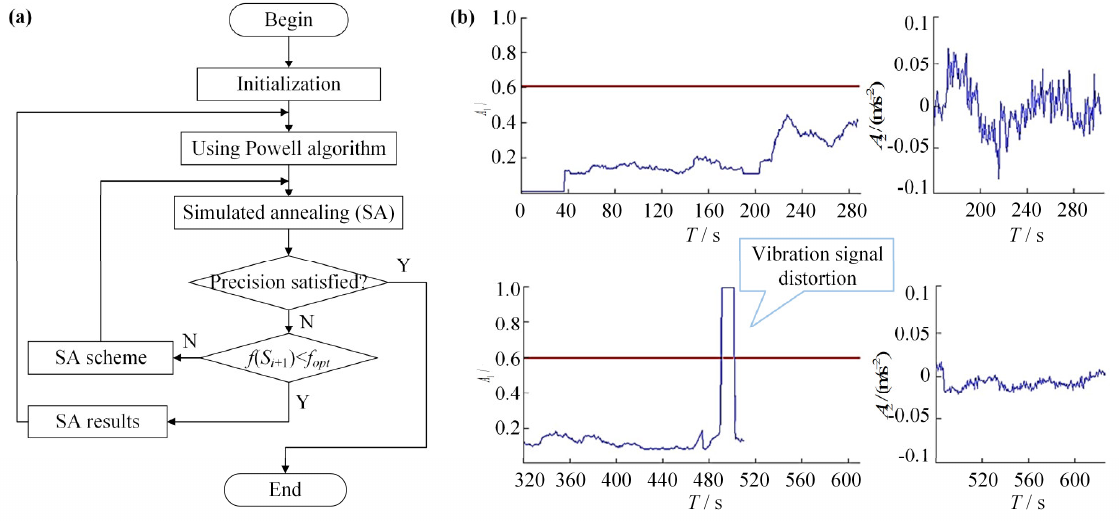
Figure 3. Recognition of vortex sucking slag based on SA–ANN algorithm. ( a ) Algorithm implementation. ( b ) Vibration signal distortion feature. (Reprinted with permission from Ref. [41]. 2013, IEEE.)